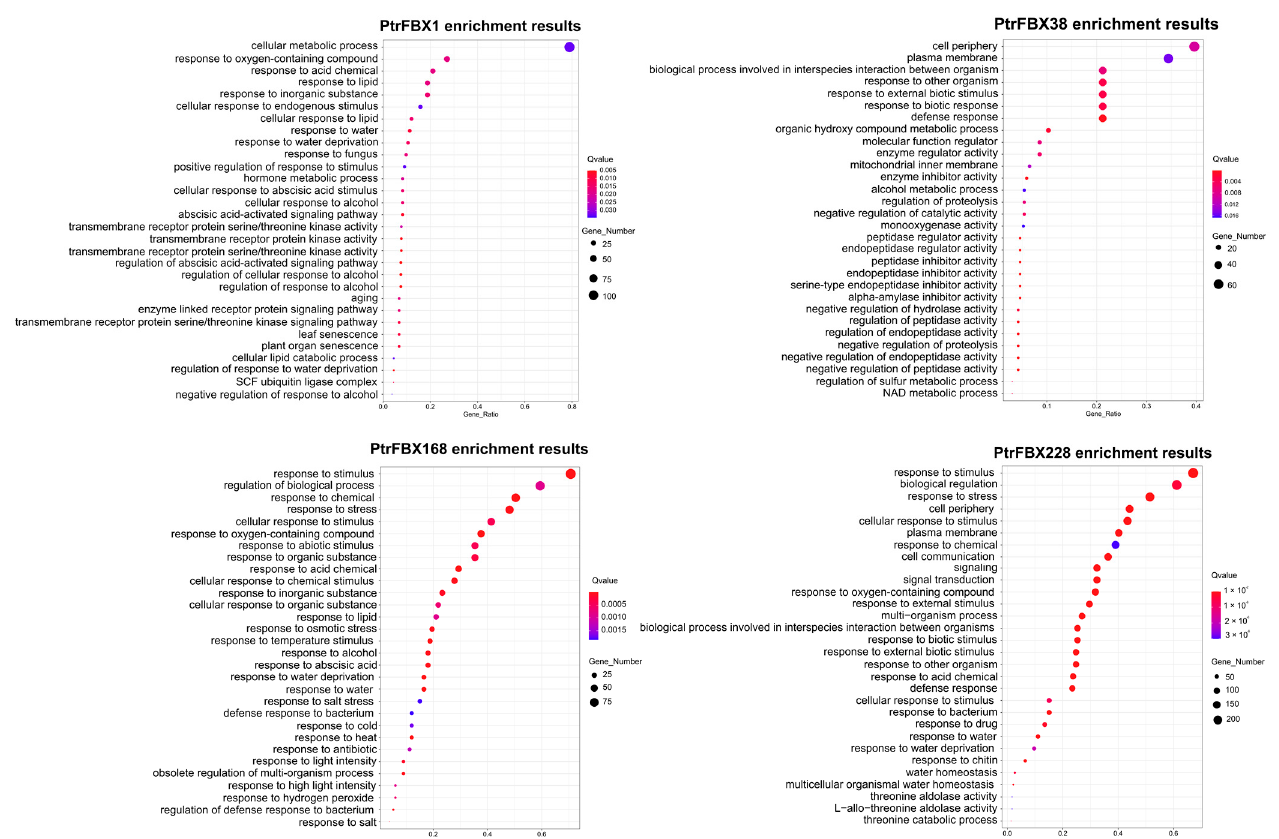
Figure 8. The top 30 significant GO enrichment annotations of the four representative gene sets. The Q value is represented by color (red and purple): the darker the red, the smaller the Q value; on the contrary, the closer to purple, the larger the value. The size of the circle represents the number of enriched genes in a certain pathway. The larger the circle, the more genes are enriched in that pathway.